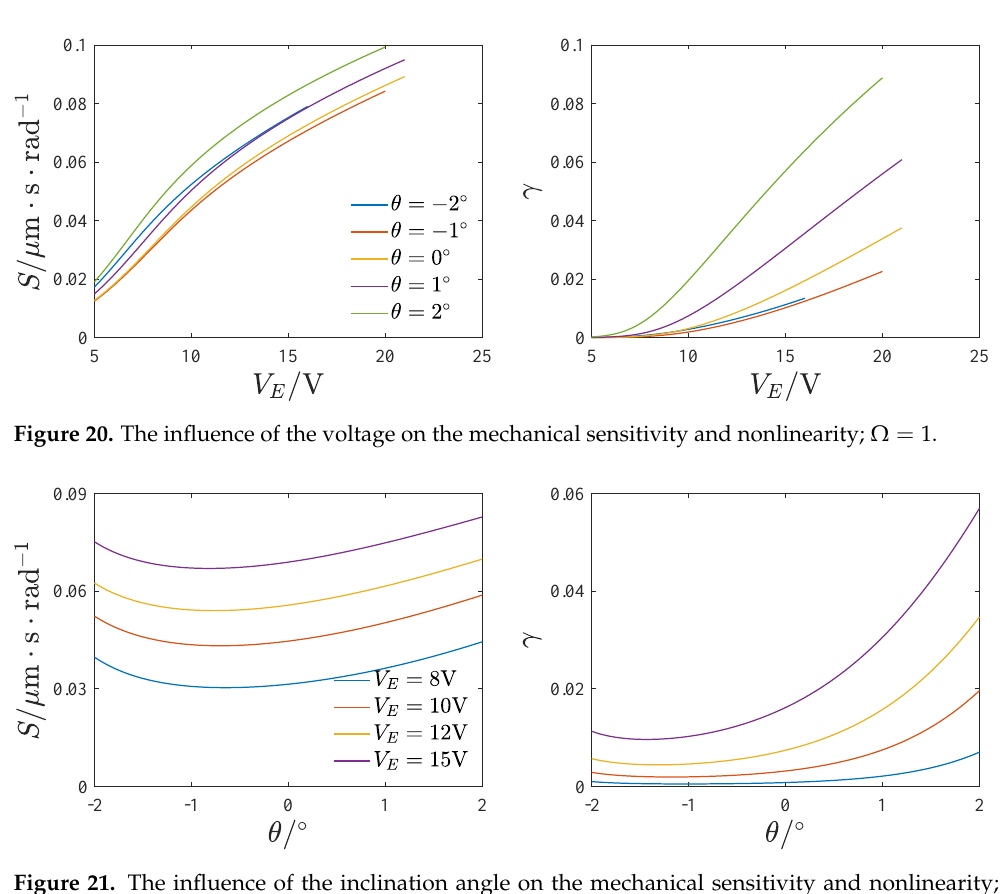
Figure 21. The influence of the inclination angle on the mechanical sensitivity and nonlinearity; Ω =